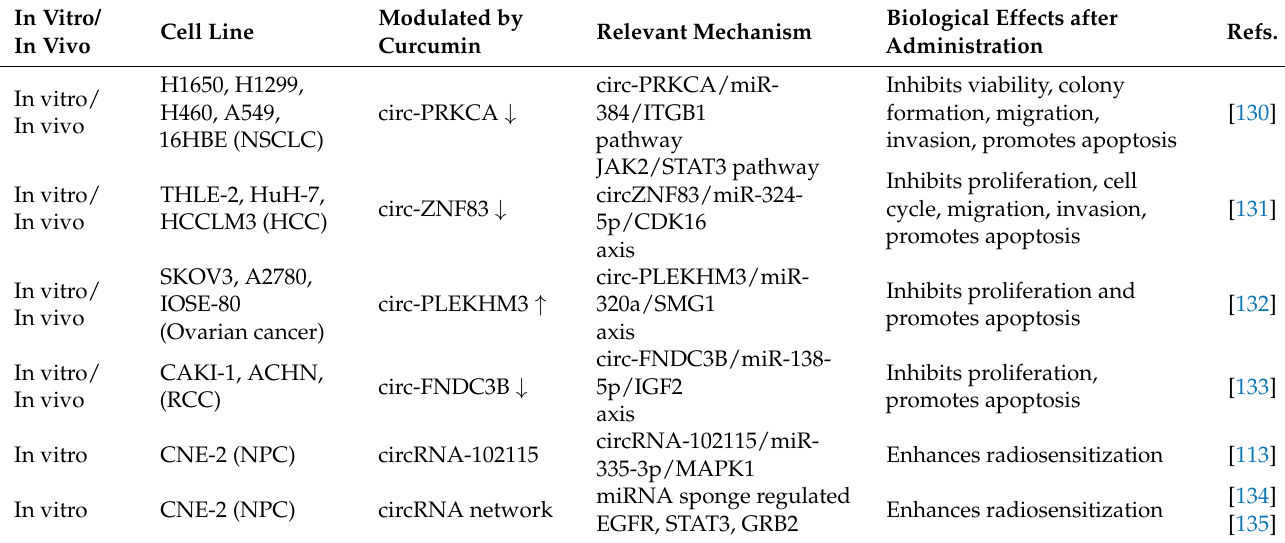
Table 3. Curcumin modulates circRNAs in various